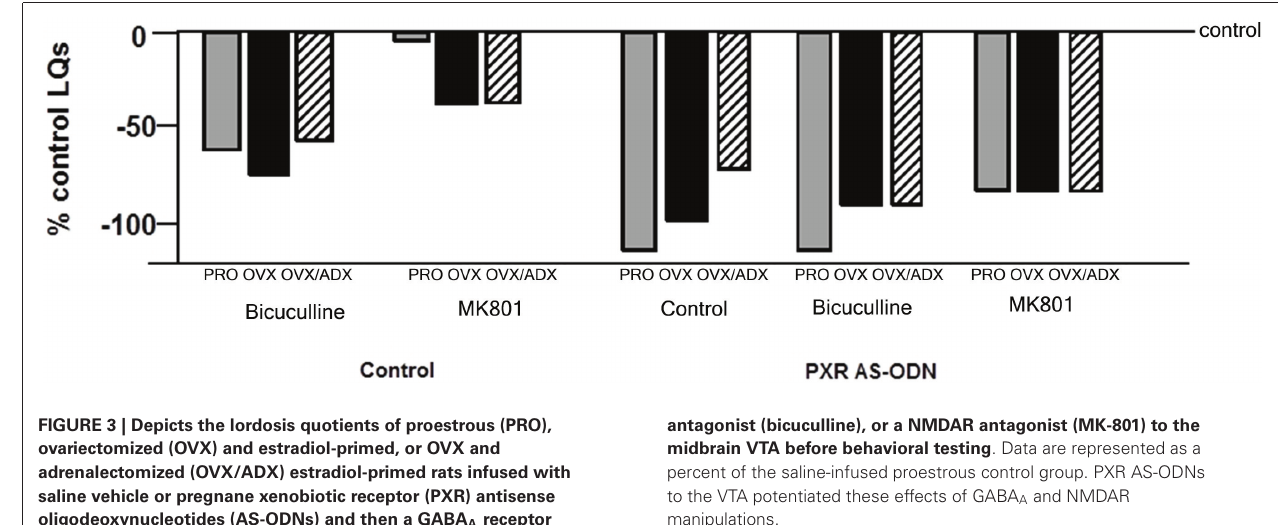
antagonist (bicuculline), or a NMDAR antagonist (MK-801) to the midbrain VTA before behavioral testing . Data are represented as a percent of the saline-infused proestrous control group. PXR AS-ODNs to the VTA potentiated these effects of GABA A and NMDAR